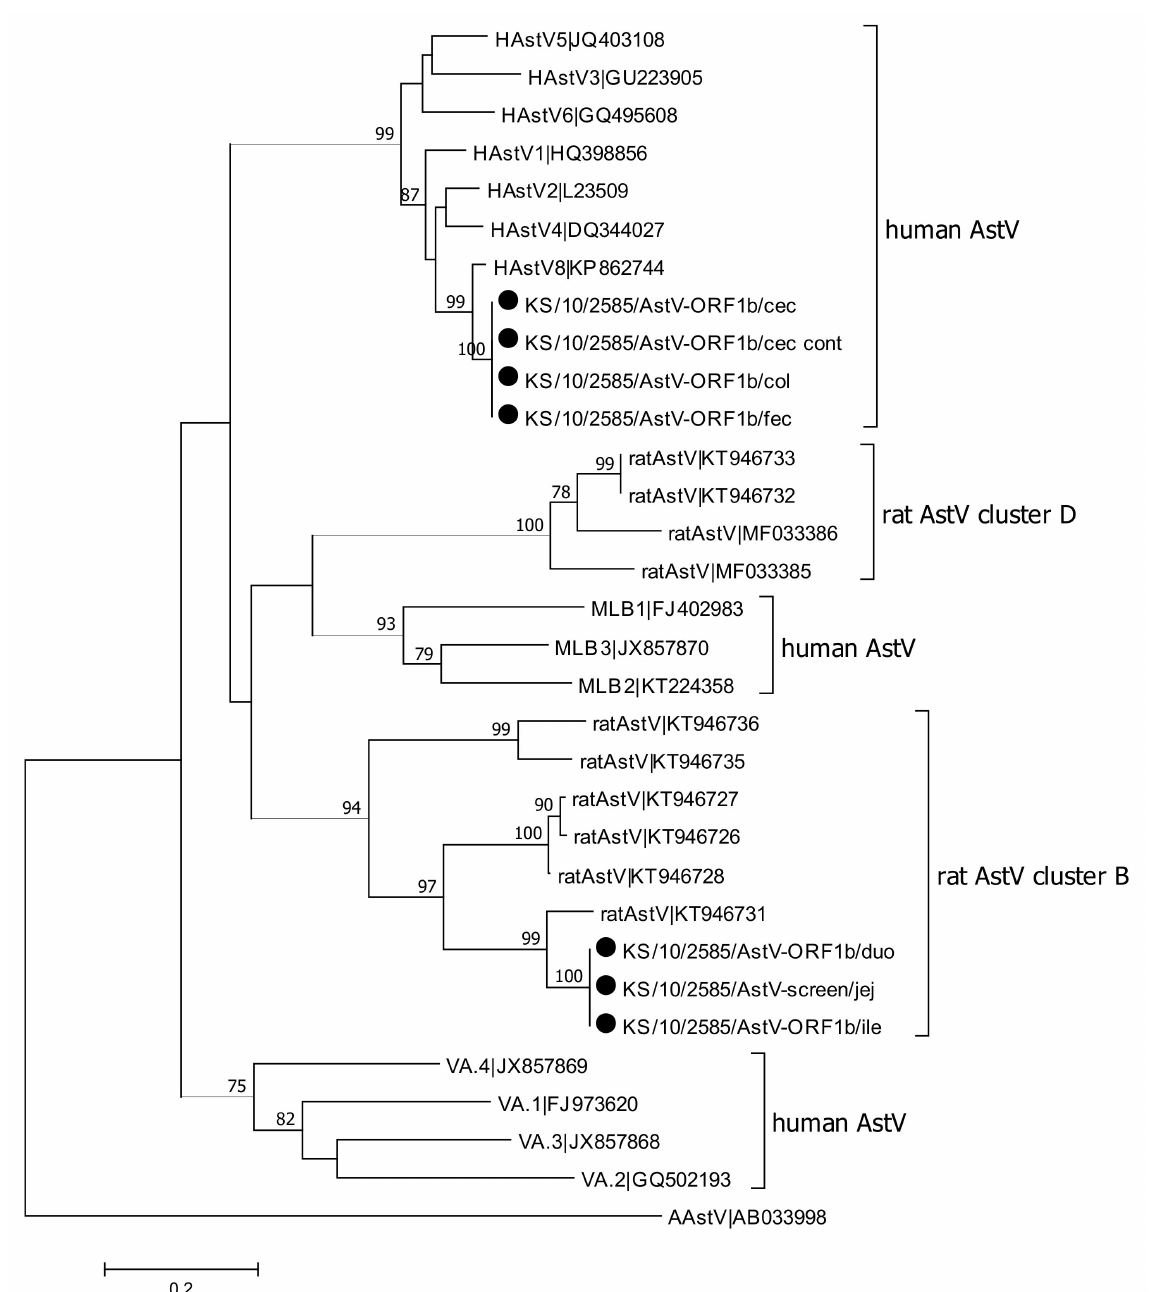
Figure 2. Phylogenetic tree of a 581 nt alignment of ORF1b region of the novel astrovirus (AstV) strains detected in this study (denoted by dot) and AstV reference sequences (accession numbers are indicated). The tree was reconstructed using the Maximum Likelihood method based on the Tamura-3-parameter model with Bootstrap test (1000 replicates). Bootstrap values above 70 are shown. An avian astrovirus sequence (AAstV|AB033998) was used as outgroup. The bar indicates the number of substitutions per site. Abbreviations: cec = cecum; cont = content; col = colon; duo = duodenum; fec = feces; ile = ileum; jej =